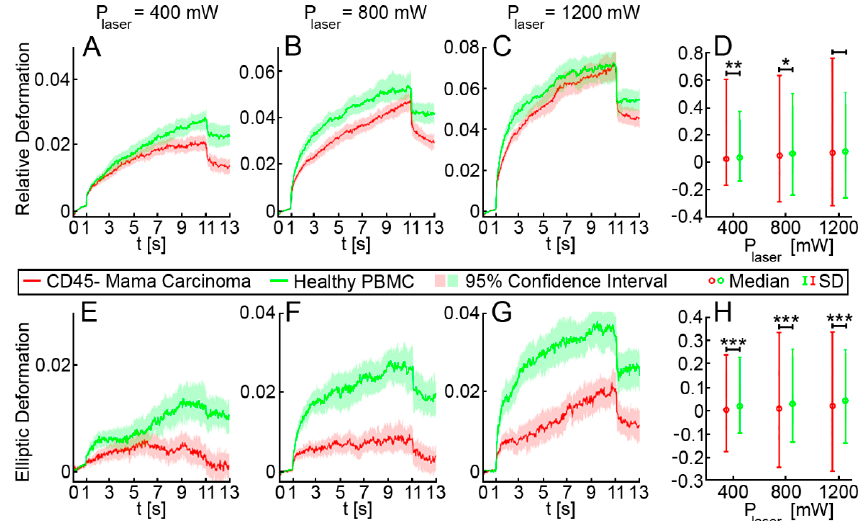
Figure 3. Relative and elliptic deformation curves of blood cells compared to non-hematopoietic CTC candidates from mamma carcinoma patients. In total, we analyzed 2541 CD45 positive PBMC from 3 healthy donors and 2 patients with breast cancer (green lines) and 3641 non-hematopoietic cells derived from 12 patients with breast cancer (red line). Measurements were carried out using three different laser powers P1 = 400 mW, P2 = 800 mW and P3 = 1200 mW, resulting in three different step stresses. ( A – C ) show the pooled relative deformation curves of possible CTC candidates from mamma carcinoma compared to PBMC at each laser power. The deformation behavior of the two cell populations appeared to be similar, and only at P = 400 mW and P = 800 mW the deformation curves differed significantly at the end of the stretching phase ( p = 0.001), as shown in ( D ). ( E – G ) show the elliptic deformation of the two cell populations at each laser power. The ellipticity of CTC candidates and PBMC differed significantly at each laser power indicating that in PBMC the elliptic deformation was increased by the factor 2 ( p (P = 400 mW) < 0.001, p (P = 800 mW) < 0.001 and p (P = 1200 mW) < 0.001). (H) Elliptic deformation of CTC candidates derived from patients with mamma carcinoma was significantly lower at all laser powers compared to CD45 positive PBMC. Asterisks indicate significance of the Kolmogorov-Smirnov-test (*— p < 0.05; **— p < 0.01; ***— p < 0.001).